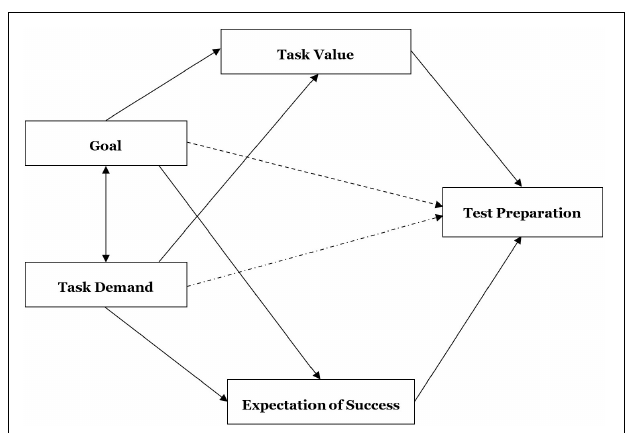
FIGURE 2 | Theoretical models